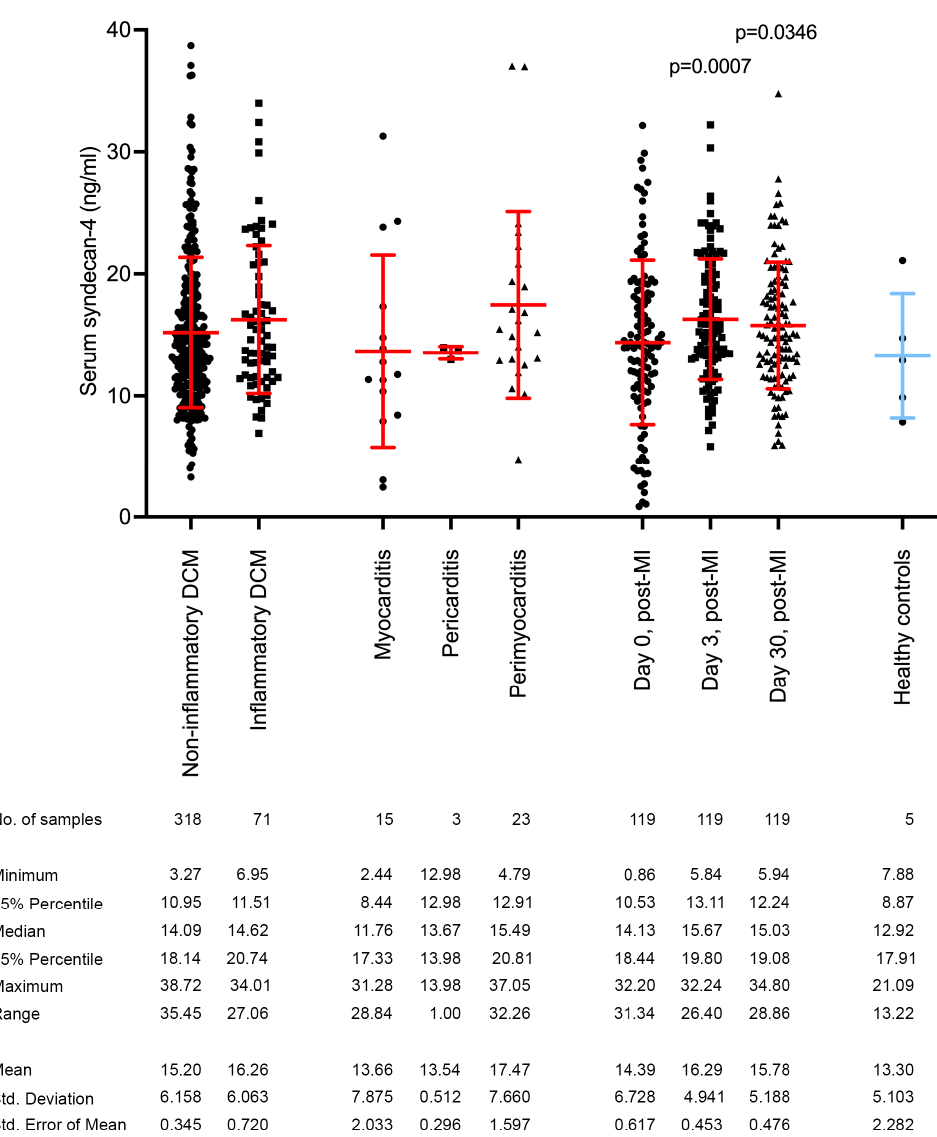
Figure 3. Serum syndecan-4 levels do not reflect the inflammatory status of the heart in patients with heart disease. Serum samples were collected from patients with cardiomyopathy of various etiologies. Patients were extensively characterized. Serum syndecan-4 levels (ng/mL) were measured by enzyme-linked immunosorbent assay (ELISA) by one experienced researcher blinded to patient characteristics. The cohort ( n = 430) consisted of subgroups with specific diagnoses, i.e., inflammatory ( n = 71) and non-inflammatory ( n = 318) dilated cardiomyopathy (DCM), myocarditis ( n = 15), pericarditis ( n = 3) and perimyocarditis ( n = 23). Serum samples were obtained from n = 119 patients with acute myocardial infarction (MI), with or without ST-elevation, at day of admission (day 0), day 3 day and day 30 post-MI. We included serum samples from n = 5 healthy controls. Data in the graph are presented as individual data points and mean ± S.D for patients (red) and controls (blue). The numerical data supporting the graph can be found in supplementary Table S2. Descriptive statistics are included underneath the graph. Statistical di ff erences were tested using ordinary or repeated measures one-way ANOVA with Tukey’s post hoc test (ordinary: myocarditis, pericarditis and perimyocarditis; repeated measures: post-MI cohort) or Student’s unpaired t-test (in fl ammatory vs. non-in fl ammatory DCM).